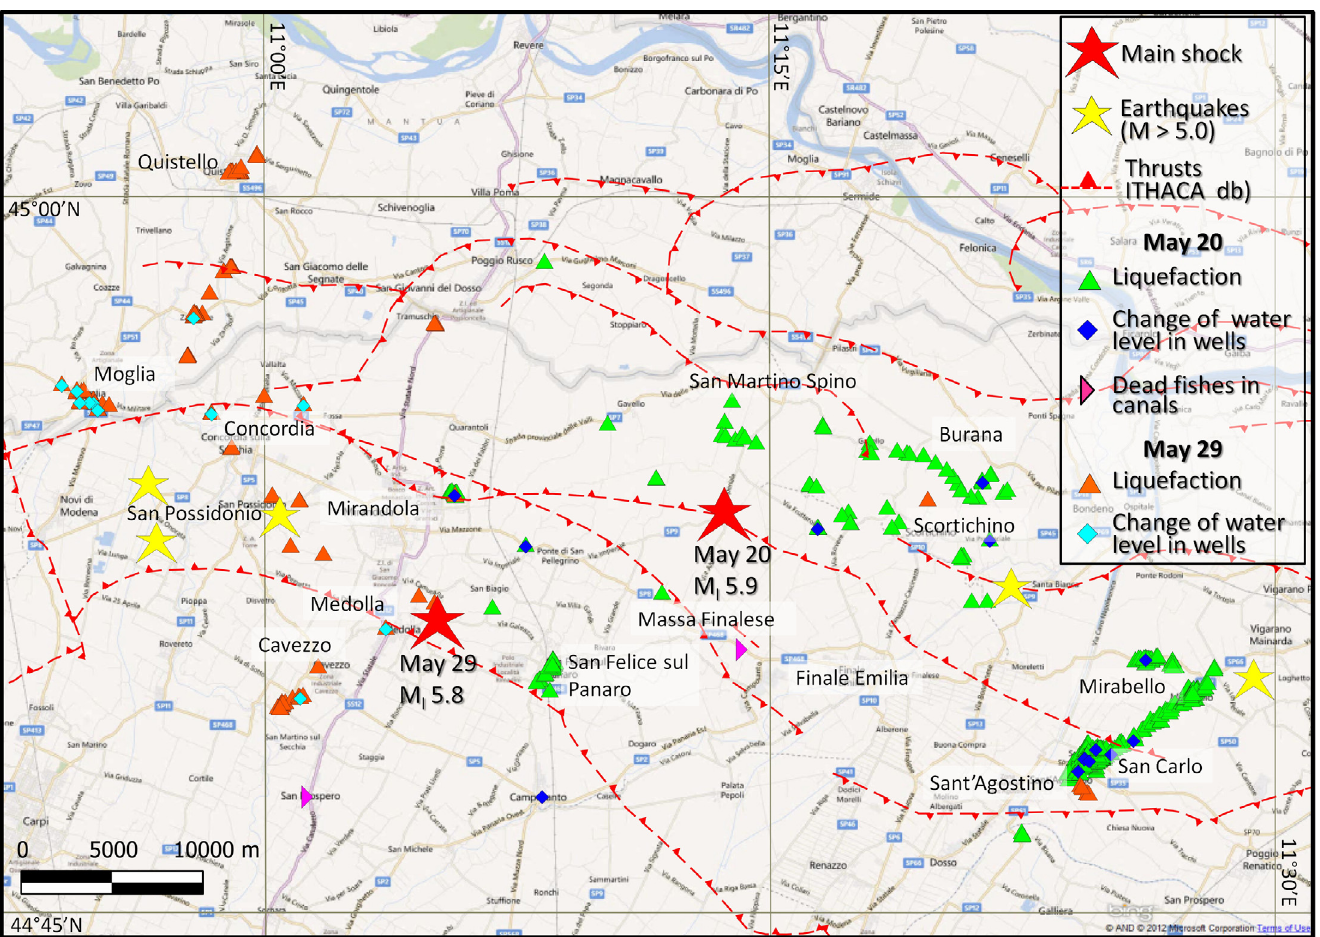
Figure 1. Main shocks of the 2012 Emilia sequence and locations of coseismic effects. Red lines are buried thrusts, many of them judged capable of caus- ing coseismic surface deformation (source: